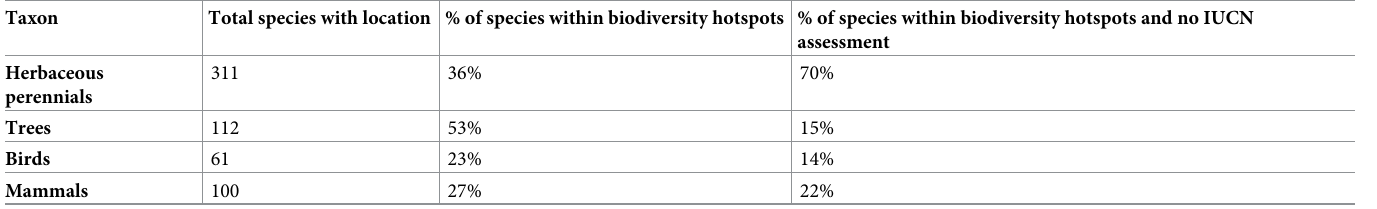
Table 3. Percentages of species per taxa with location within biodiversity hotspots.